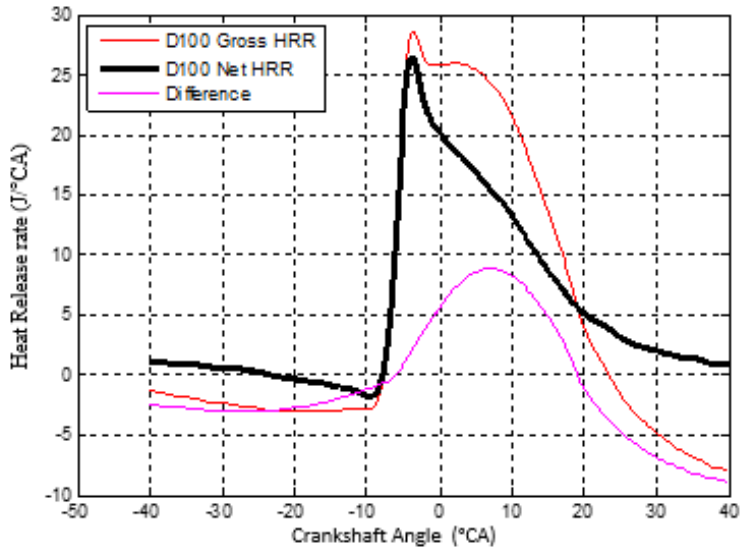
Figure 14. Profile of net heat release rate (Net HRR) evolution and gross heat release rate (Gross HRR) for engine speed n = 1500 rpm at 50% load according to D100 combustion.